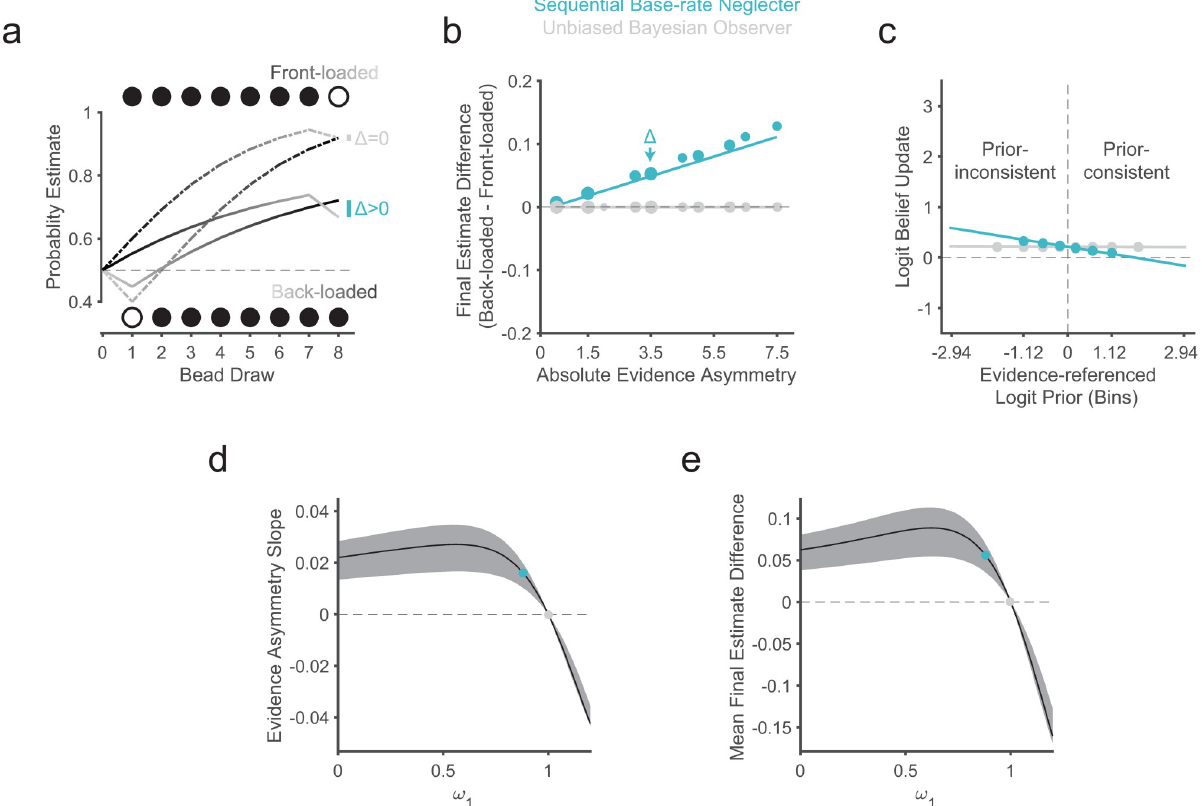
Fig 2. Model predictions for sequential base-rate neglect under the weighted Bayesian model. An agent with sequential base-rate neglect ( ω 1 < 1.00; for these simulations: ω 1 = 0.88), in blue, is compared with a Bayesian ideal observer ( ω 1 = 1), in grey, on the 60:40 bead-ratio condition. Values of ω 2(60:40) are 0.51 (or between 0.31 and 0.66 in the shaded regions in panels d-e) consistent with observed mean values (and 25 th to 75 th percentile range) in our prior work with a similar beads task [31]. (a) Simulated sequential probability estimates for two mirror-opposite sequences for a base-rate neglecting agent (blue/solid) and the ideal Bayesian observer (grey/dashed). Majority beads are shown as black and minority beads as white for illustrative purposes. Belief trajectories for front-loaded sequences show a gradient from dark to light and those for the back-loaded sequences transition from light to dark (b) Simulation of the recency bias, defined as the difference between the final probability estimate after 8 beads between mirror-opposite pairs, as a function of the absolute evidence asymmetry of the pairs. As in Fig 1, larger circles reflect sequences with more majority beads. The fit line shows the fixed effect of absolute evidence asymmetry on the final estimate difference. The simulated base-rate neglecter shows higher estimates for back-loaded sequences (compared to their front-loaded mirror opposites), particularly for sequence pairs with more evidence asymmetry. This effect varies with evidence strength and is strongest in the 90:10 condition (S2A Fig). See S2E Fig for a simulation of an agent that overweights the prior. The lower-case delta shows the example from (a). (c) Simulation of the magnitude of logit-belief updates as a function of the prior with respect to the color of the current evidence. For illustrative purposes, the x-axis has been discretized into bins equivalent to 0.1 increments of prior beliefs in probability space. The y-axis represents the mean magnitude of the logit belief updates (the difference in the log-odds of the prior and the posterior belief). The Bayesian ideal observer has constant logit belief-updates. In contrast, the simulated base-rate neglecter shows logit-belief updates that depend upon the prior belief, with relatively larger updates for prior-inconsistent evidence (left of the vertical dashed line) and smaller for prior-consistent evidence (right) (see S2B Fig for a condition-wise simulation). The fit line reflects the fixed effect of logit-prior on the logit-belief update, which we refer to as prior-dependent belief updating. The model predicts main effects of logit-prior and bead-ratio condition, but no interaction S2B Fig. See S2D Fig for a simulation illustrating the distinct scaling effects of ω 2 and S2F Fig for a simulation of an agent that overweights the prior. (d) Simulation demonstrating the predicted relationship between ω 1 and the evidence asymmetry slope (blue fit line from b). (e) Simulation of the predicted relationship between ω 1 and mean final estimate difference (average of blue data points in b). (d,e) The blue and grey dots show the values for the base-rate neglecting and Bayesian ideal observers simulated in (a,b,c) .